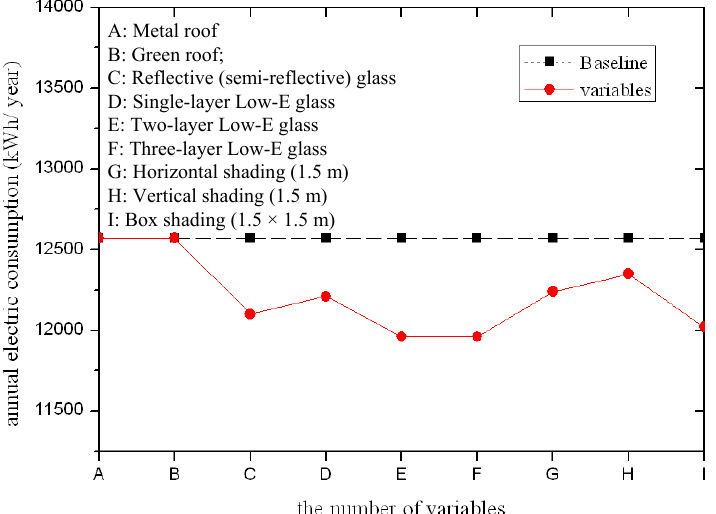
Figure 10. Comparison of annual electricity consumption among different